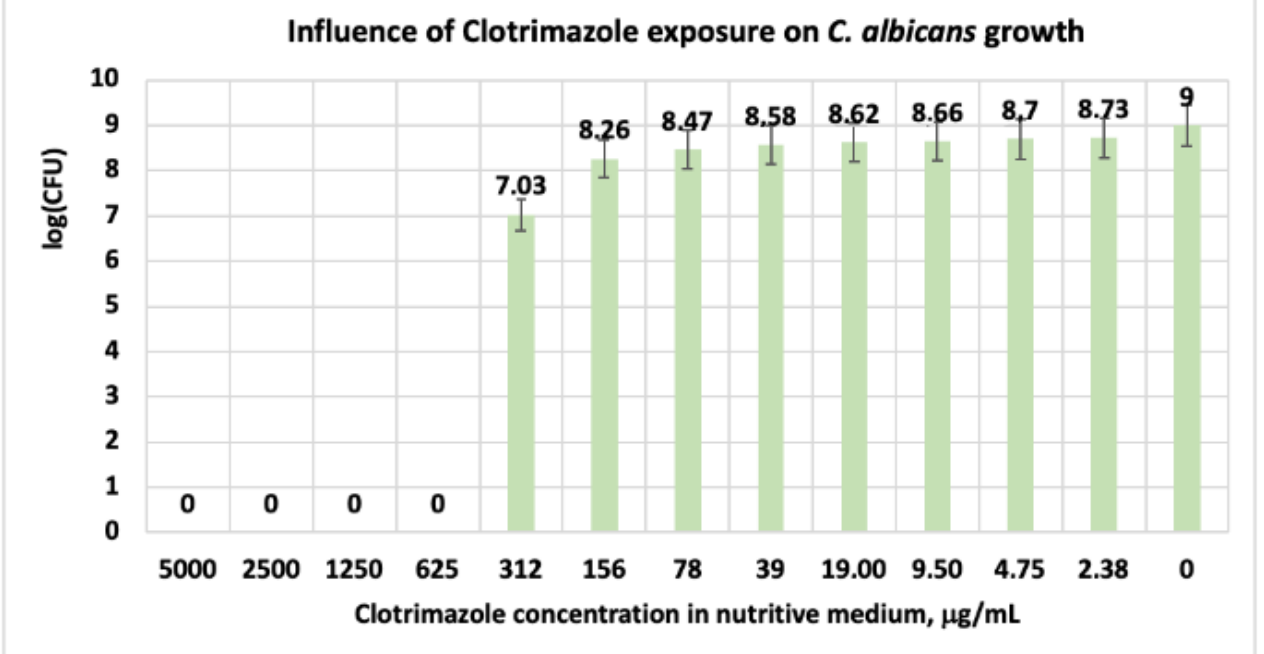
Figure 6. Influence of CT exposure on C. albicans growth, after 48 h. At a concentration of clotrimazole in the culture medium higher than 312 μg/mL, C. albicans is inhibited.